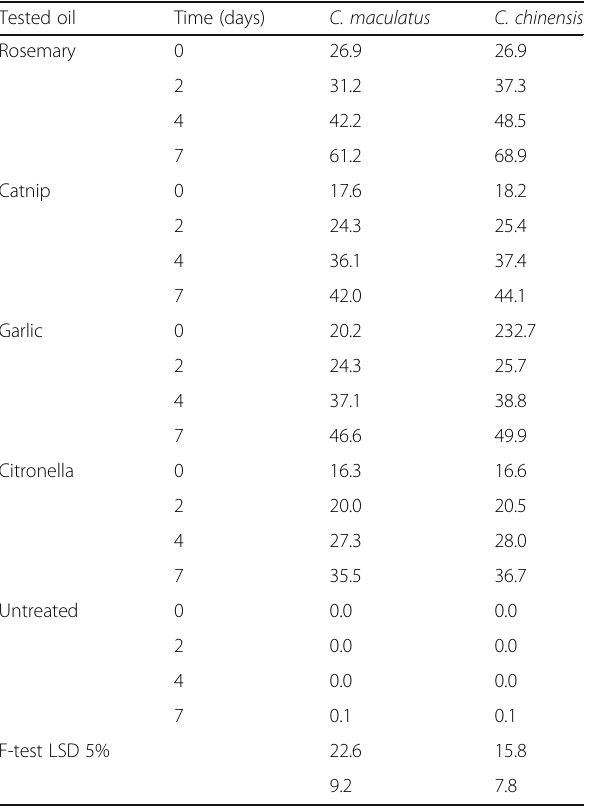
Table 1 Accumulations mortality of target adult pests during the first week of cow pea seeds in treated foam with different oils